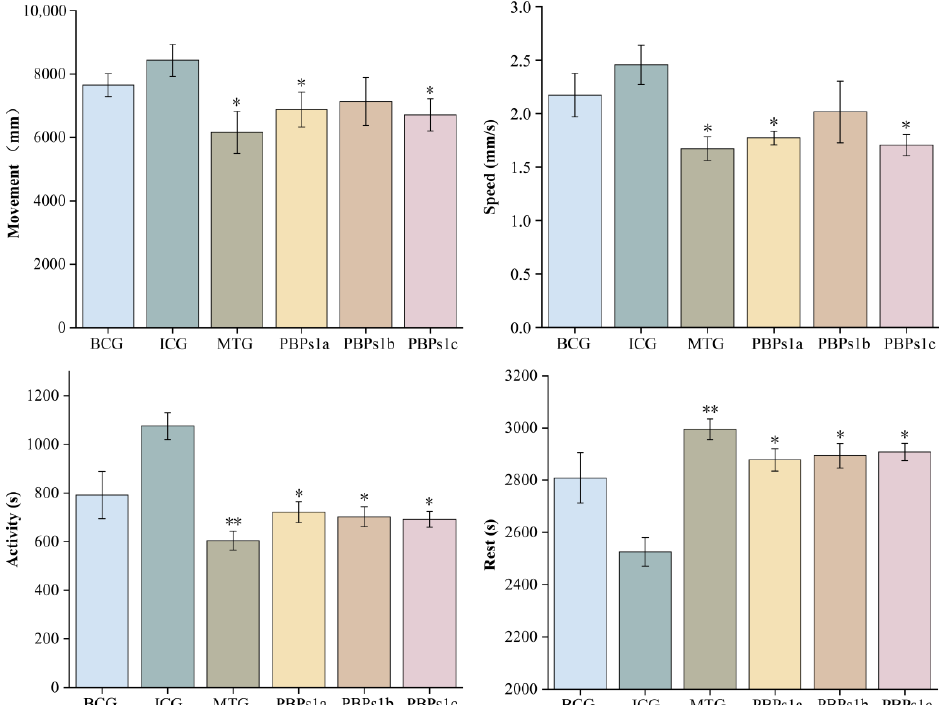
Figure 3. Changes in behavioral indicators of zebrafish after PBPs1a (0.5 mg/mL), PBPs1b (0.5 mg/mL) and PBPs1c (0.5 mg/mL) treatment. The p -values for each group were calculated by com- parison with the ICG. Blank control group (BCG), normal growth of zebrafish without adding any drugs; Insomnia control group (ICG); Positive drug (melatonin) group (MTG). Data are expressed as mean ± SD. (Student t-test, * p < 0.05, ** p < 0.01, n = 8). t -test, * p < 0.05, ** p < 0.01, n =